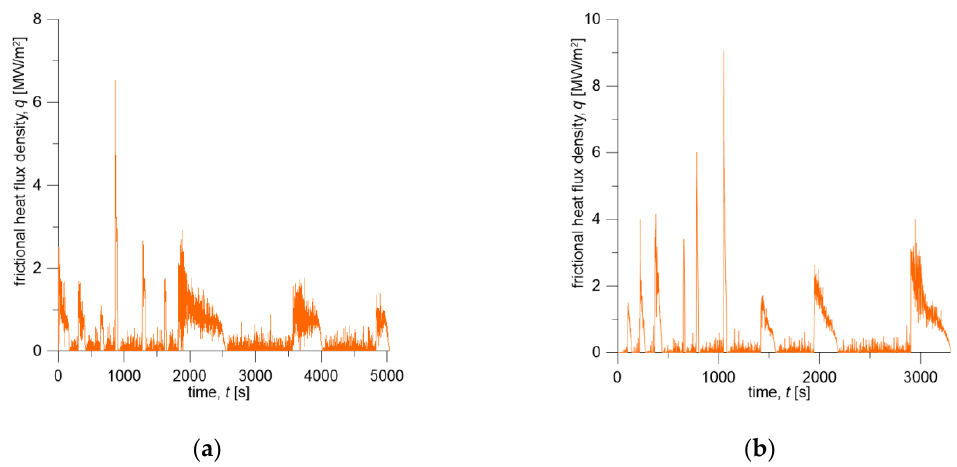
Figure 6. Changes in frictional heat flux density generated in the wheel-brake shoe contact area during during braking: ( a ) Material A—ER7; ( b ) Material braking: ( a ) Material A—ER7; ( b ) Material B—ER7.